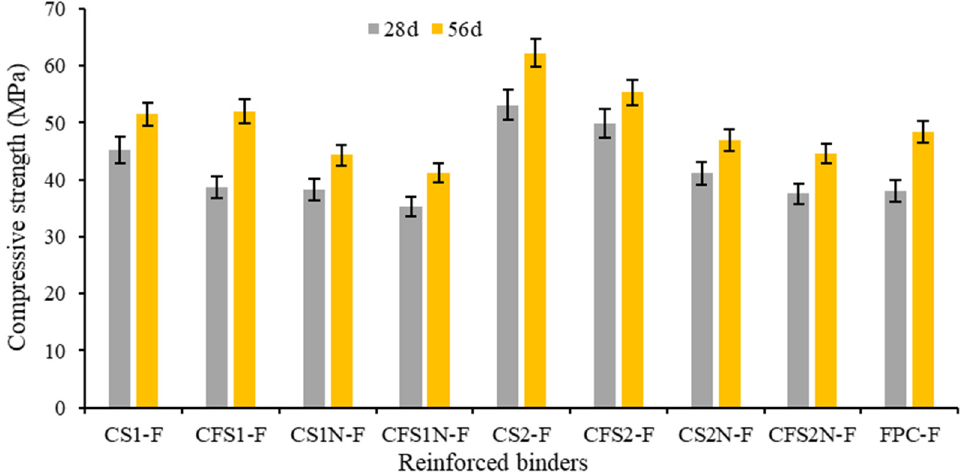
Figure 5. Compressive strength of binders with fibers (reinforced binders) at 28 and 56 days.